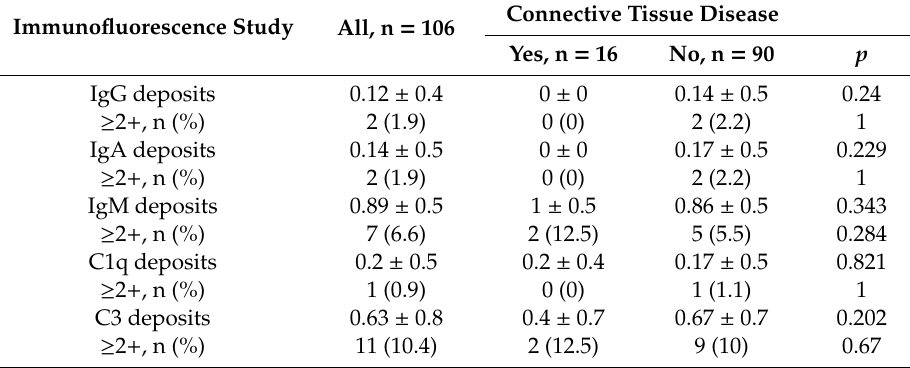
Table 4. Immunofluorescence analysis of kidney biopsy according to study groups. Deposits were graded as follows: 0, none; 1 + , weak; 2 + , moderate; 3 + , strong.